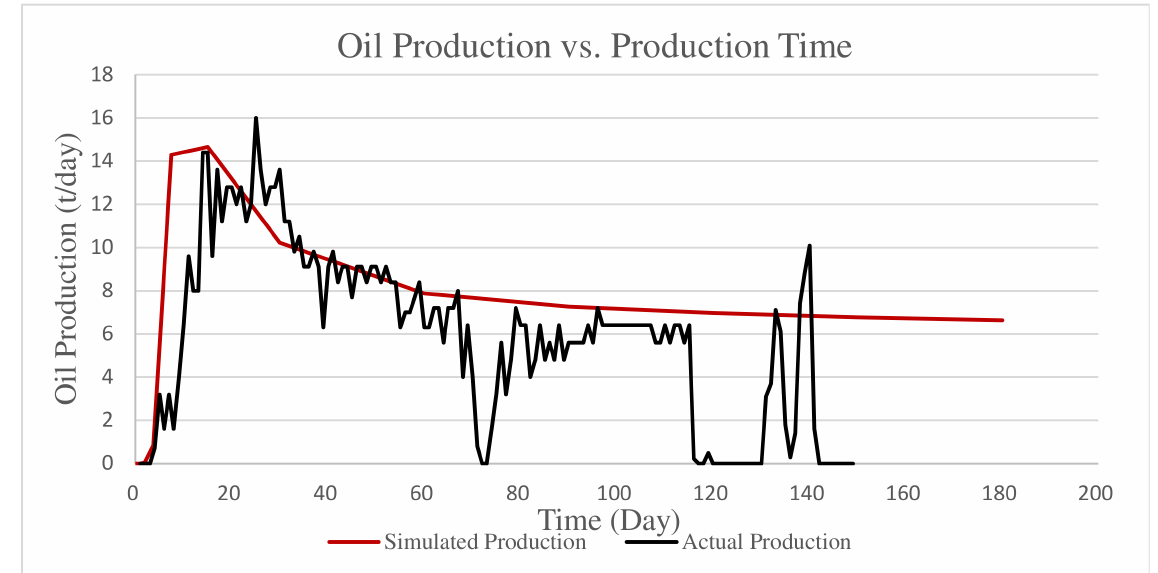
Figure 3. Plot of oil production data with